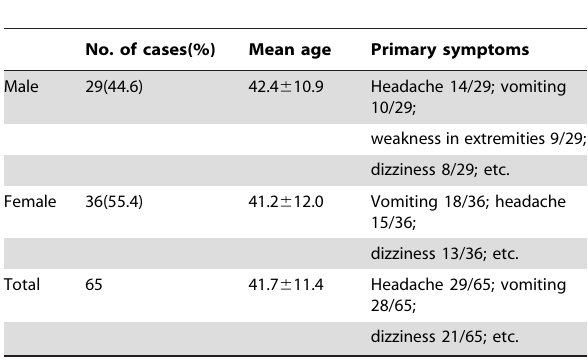
Table 1. Summary of patients with MMD in Chaoshan District. a